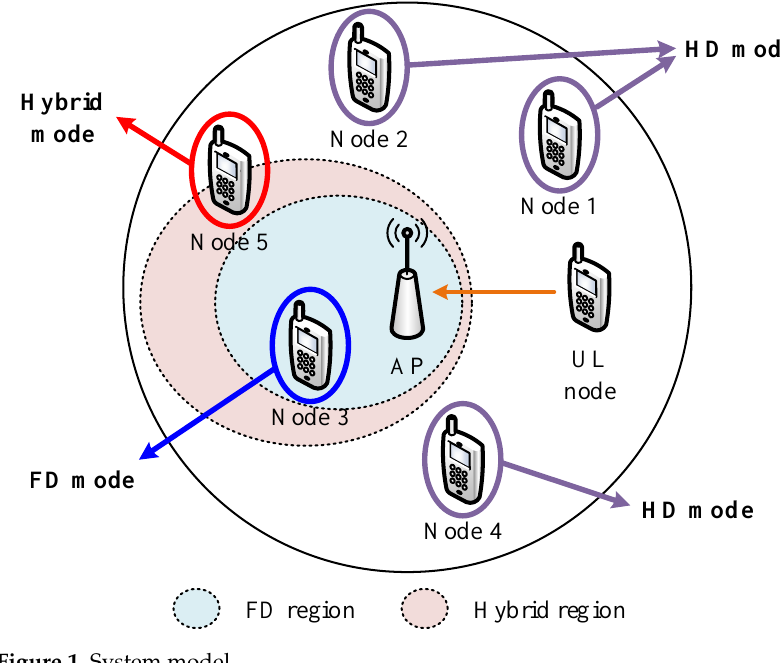
Figure 1. System